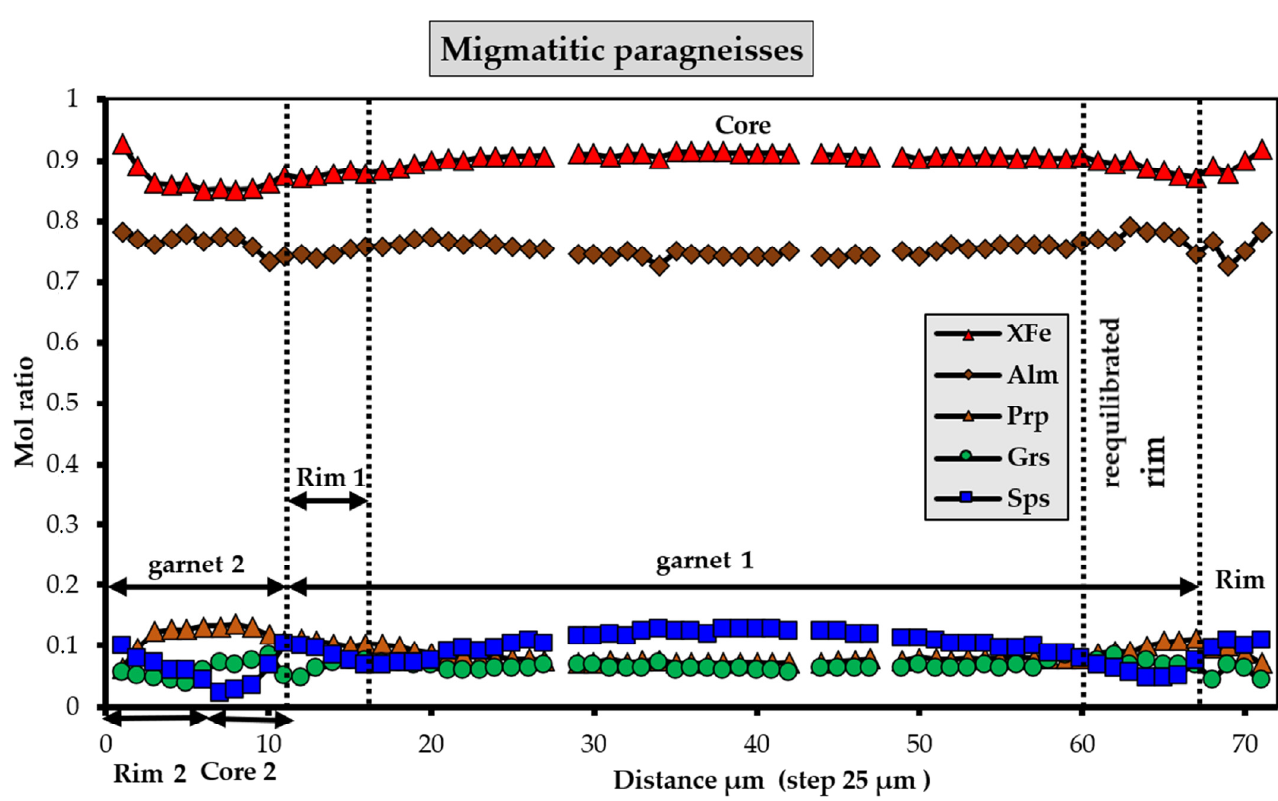
Figure 7. Chemical zoning profile of garnet from the migmatitic paragneisses of the Filali